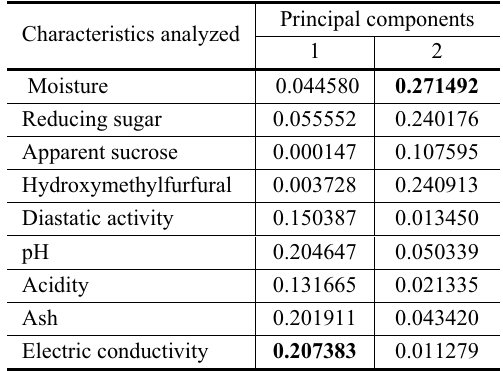
Contribution toward the formation of the principal component of physicochemical characteristics of fresh and dehumidified honey of two stingless bee